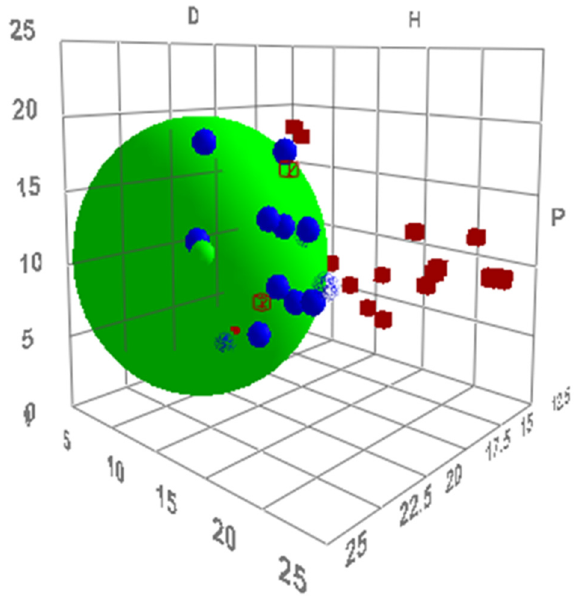
Figure 8. The Hansen sphere of compound 5 (green data point). Solvents are shown as blue data points and used to fit the sphere. Non-solvents are shown as red data points.